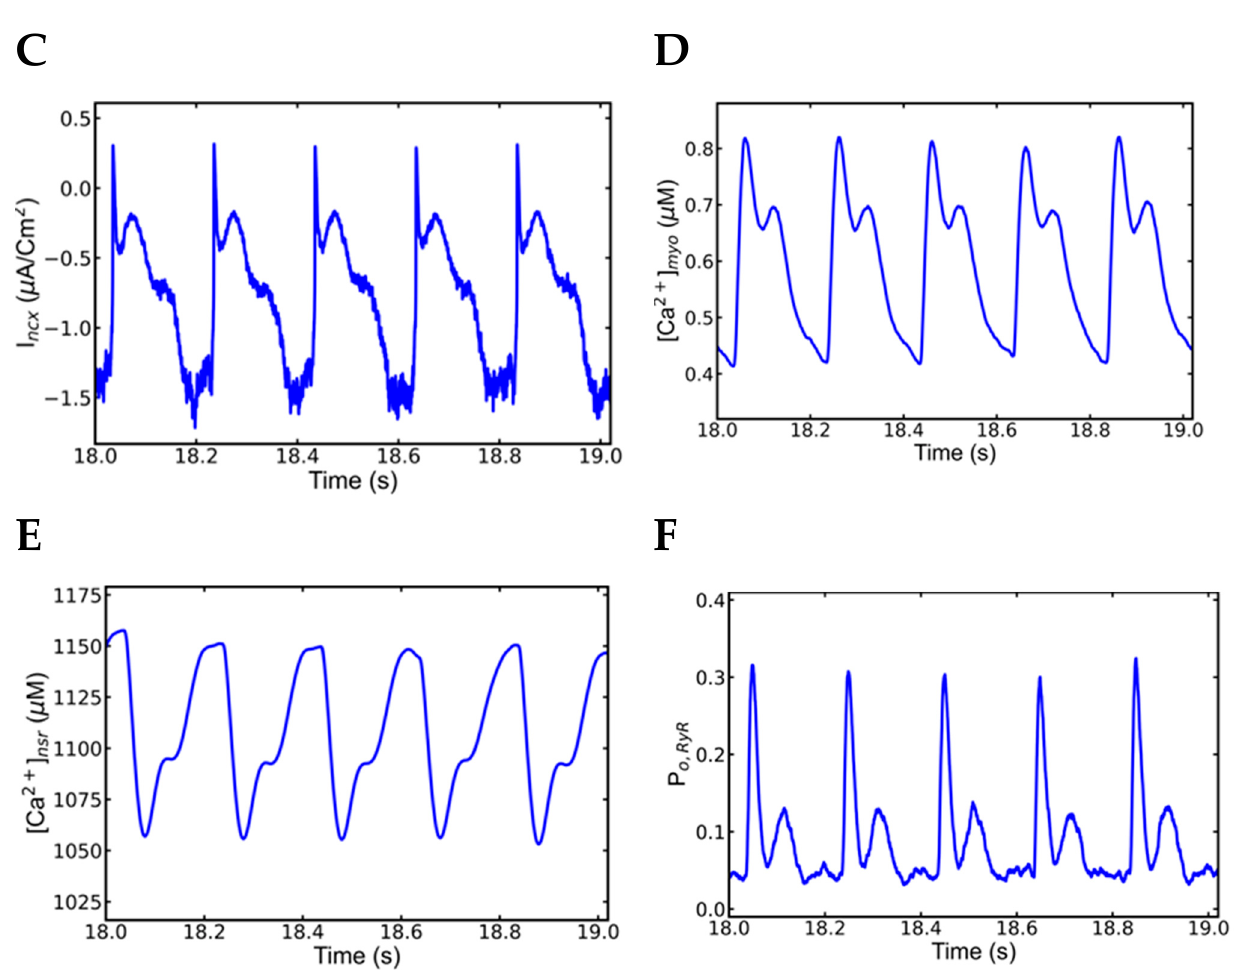
Figure 7. No EADs or alternans were recorded in 5 Hz pacing after the first slow phase pacing in mutant myocyte. A segment between 18 to 19 s was enlarged from Figure 3A to find more about the state of APs and other ionic currents during rapid pacing but none of them captured any abnormality. ( A ) action potentials ( B ) L-type channel current, ( C ) Na + -Ca 2+ exchange current (I ncx ), ( D ) Myoplasmic Ca 2+ concentration ([Ca 2+ ] myo ) ( E ) NSR Ca 2+ , [Ca 2+ ]nsr, and ( F ) RyR2 opening. The simulation was repeated 10 times with different seeds for the pseudo random number generator and the patterns observed were repeated each time. Shown here is a representative simulation.